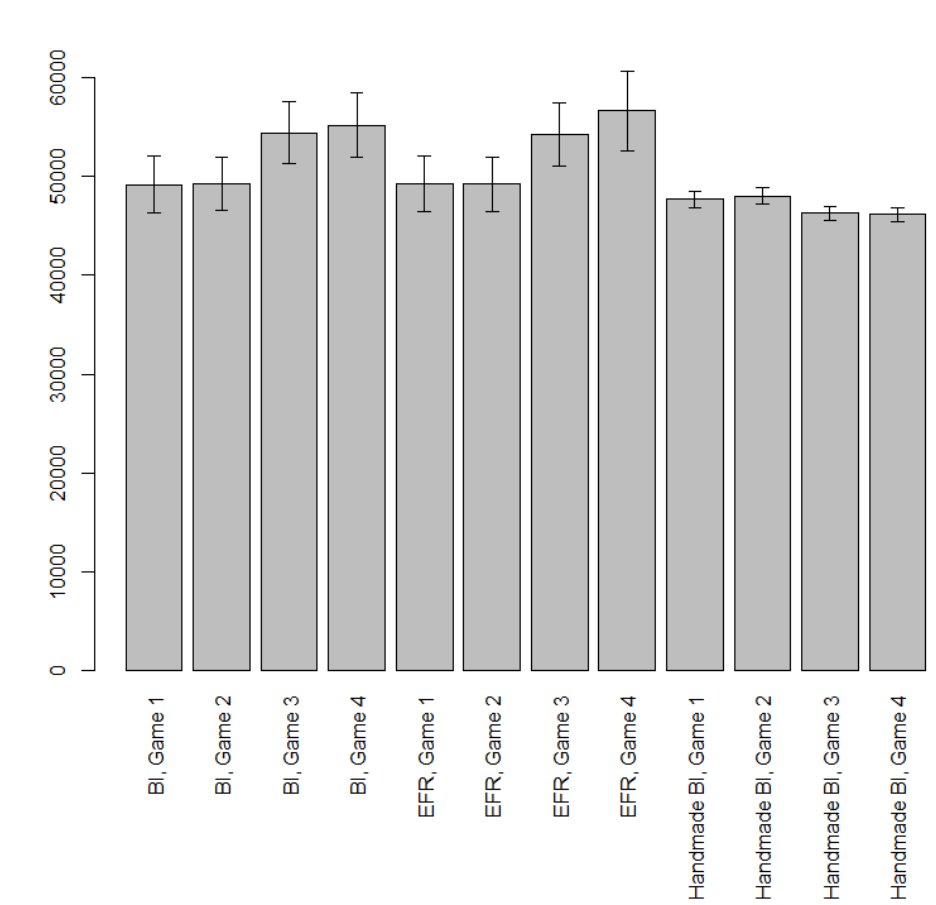
Figure 7. Reaction times in milliseconds for the automatically generated BI and EFR cognitive models and the handmade BI cognitive model in Games